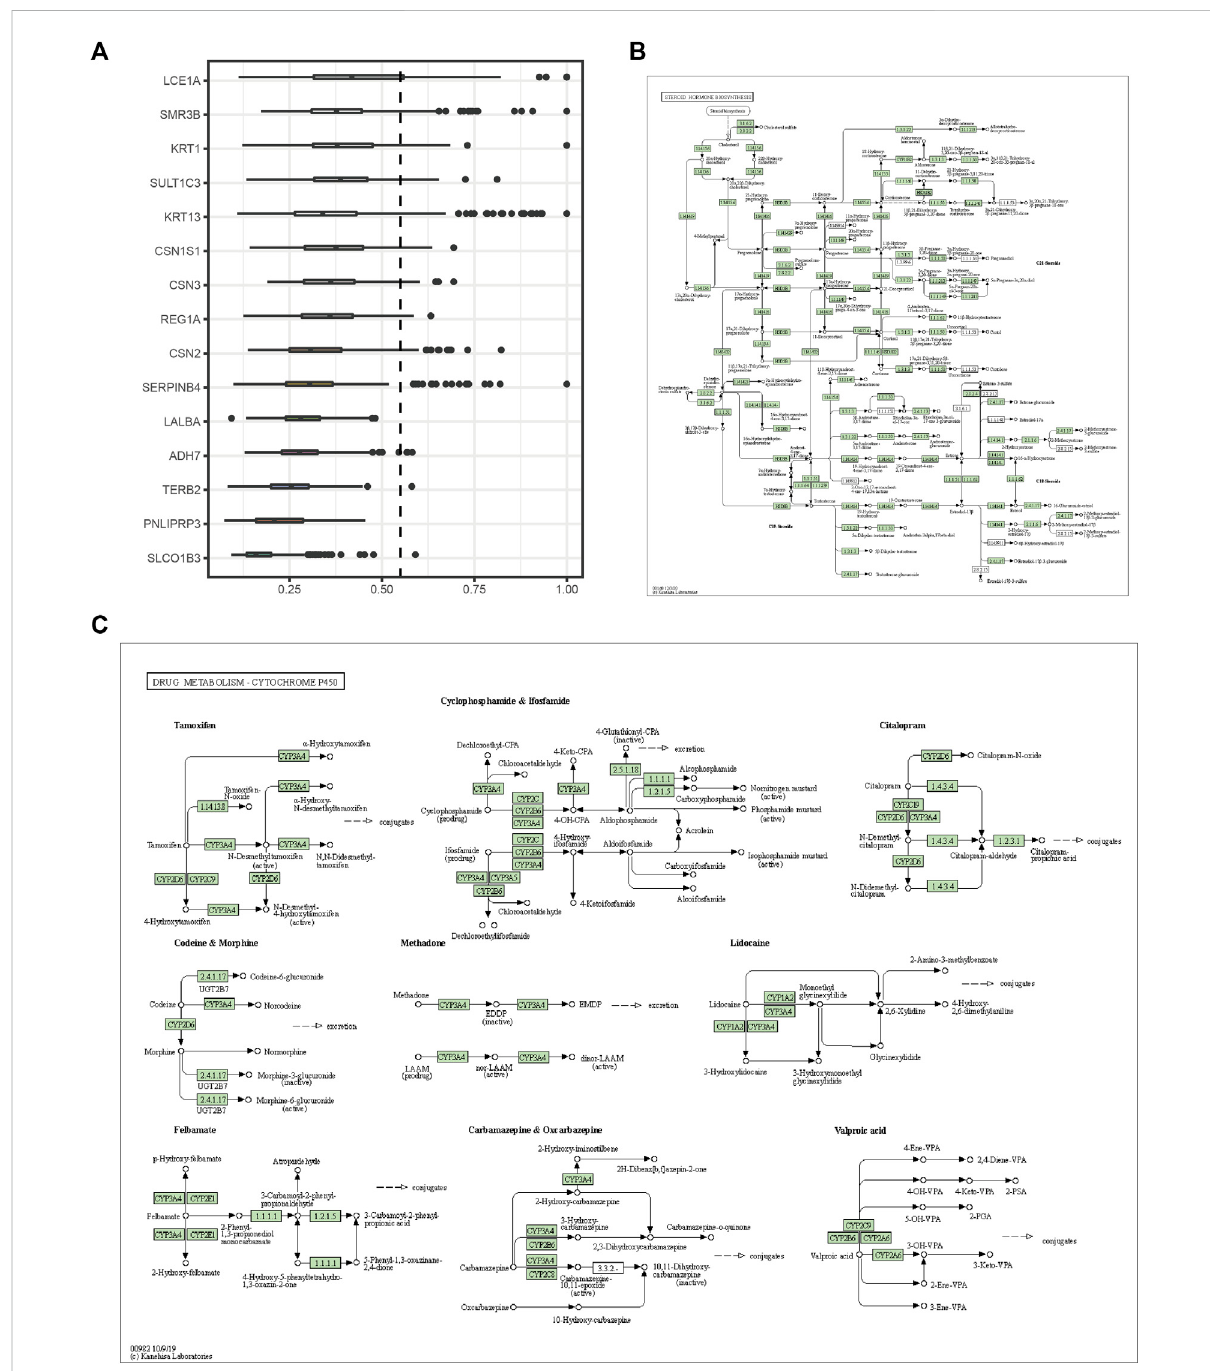
FIGURE 4 Friendsanalysisand signaling pathway diagram. (A) Thetop 15 genesthat interactwith othergenes inthepathwayfrom theFriendsanalysis. (B) Steroid hormone biosynthesis. (C) Drug metabolism-cytochrome